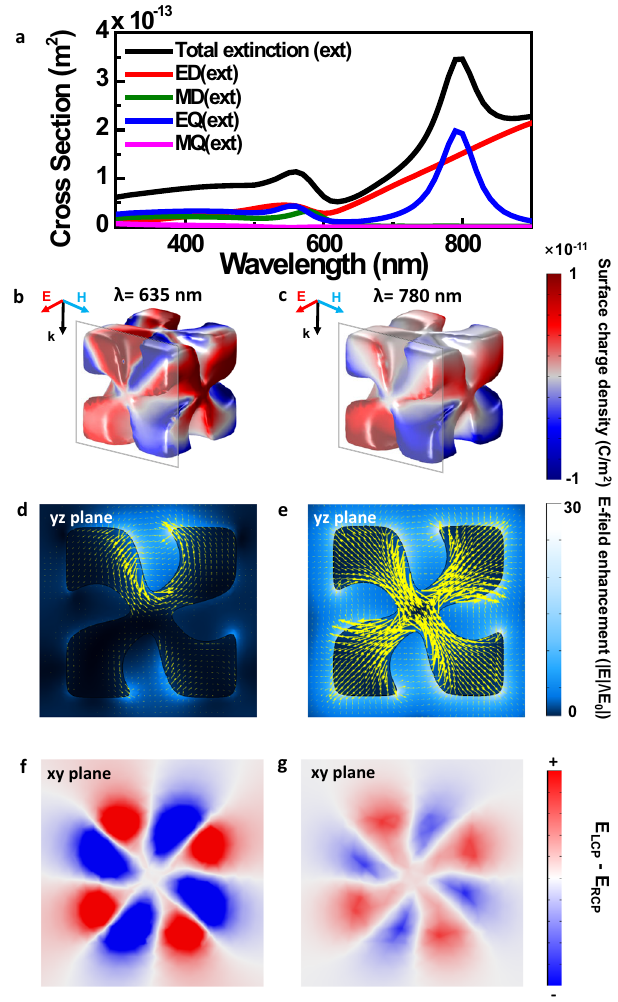
Fig. 3 | Simulation analysis of a chiral gold nanoparticle and the IGZO/chiral gold nanoparticle interface. a Multipole expansion of the total extinction of a single chiral gold nanoparticle of 180nm. b , c Surface charge distribution under linear excitation (x-polarization) with 635nm and 780nm, respectively. d , e E- fi eld enhancement and its corresponding current distribution in the yz plane (yellow arrow) at x= − 80nm under linear excitation (x-polarization) with 635nm and 780nm, respectively. f , g Difference between the E- fi eld enhancement under LCP and RCP excitation in the xy plane, which is the interface between the chiral gold nanoparticleandIGZOunder635nmand780nmlightexcitation,respectively.The integrated value is − 1.20 × 10 − 15 m 2 (635nm) and 7.10 × 10 − 15 m 2